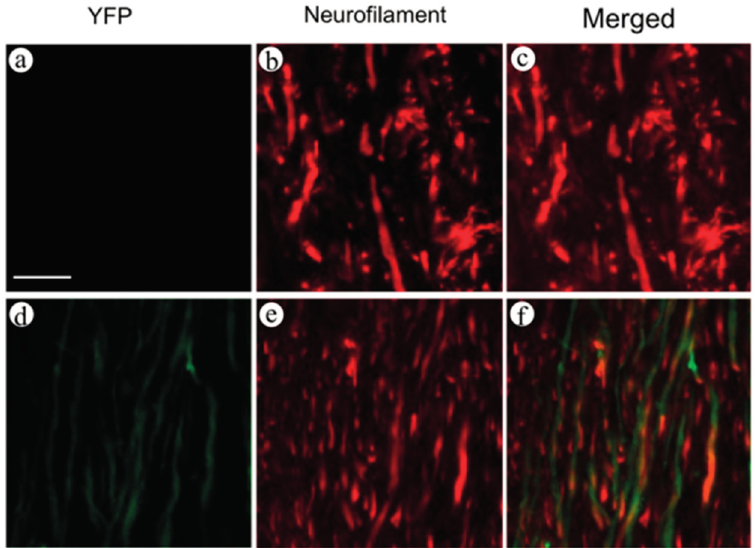
Figure 1. Double staining of neurofilaments and YFP in the spinal cord of both wild-type ( a – c ) and YFP-H mice ( d – f ). Observation was performed using conventional fluorescence microscopy. Expression of YFP was labeled with FITC ( a , d ), and neurofilaments were labeled with Cy3 ( b , e ). Merged images were c and f . Scale bar is 25 μ m.